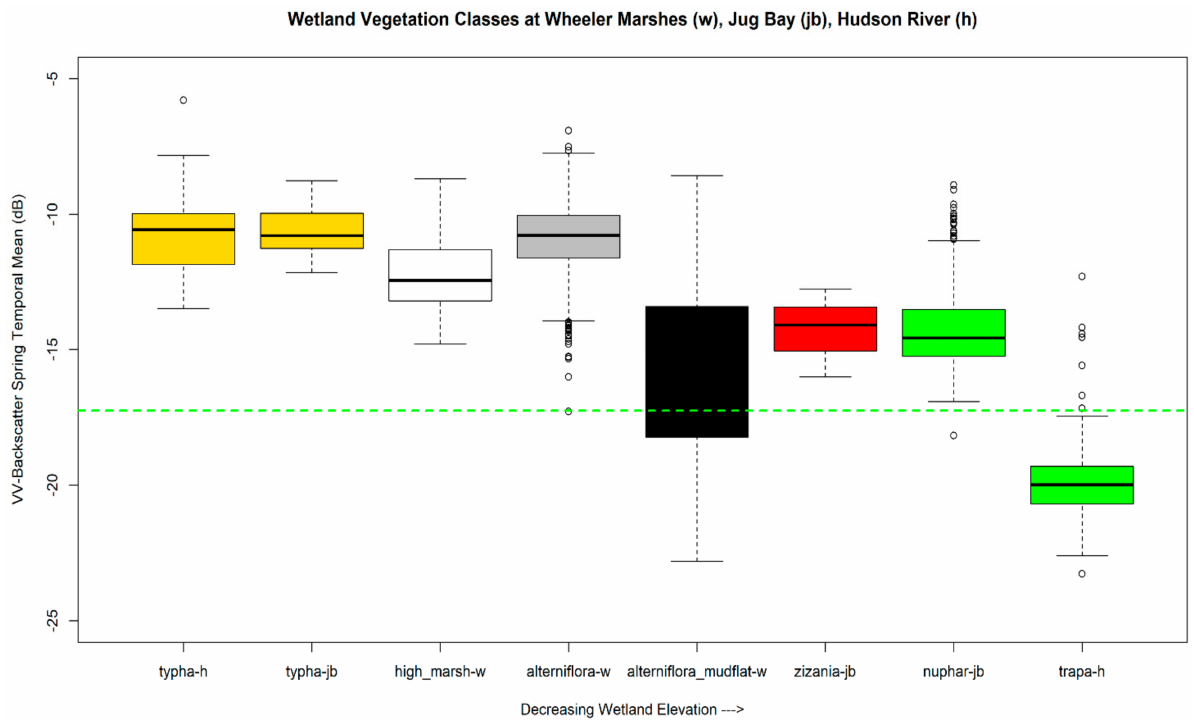
Figure 10. 2017 Sentinel-1 VV spring mean backscatter pixel values by wetland vegetation class at Wheeler Marshes (w), Jug Bay (jb), and Hudson River (h) sites. Naming convention, color schemes, and areas of extraction are the same as in Figure 9. Note with the VV spring layer, a threshold of − 17.25 dB separates T. natans from other non-persistent vegetation (horizontal dashed green